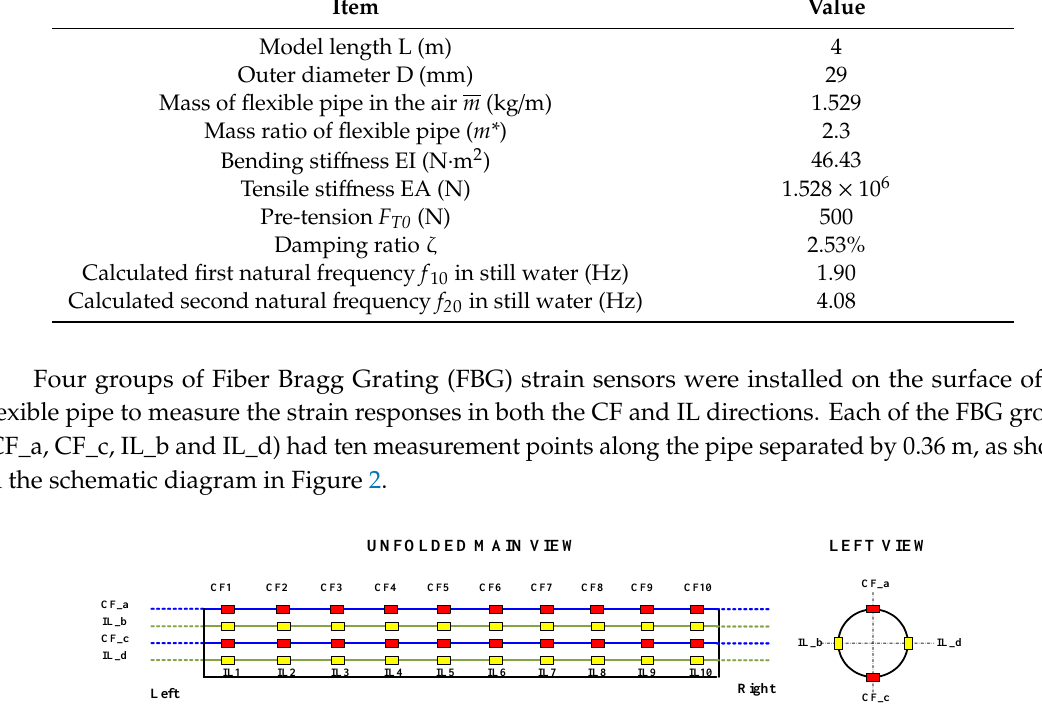
Table 2. Parameters of the flexible pipe model.